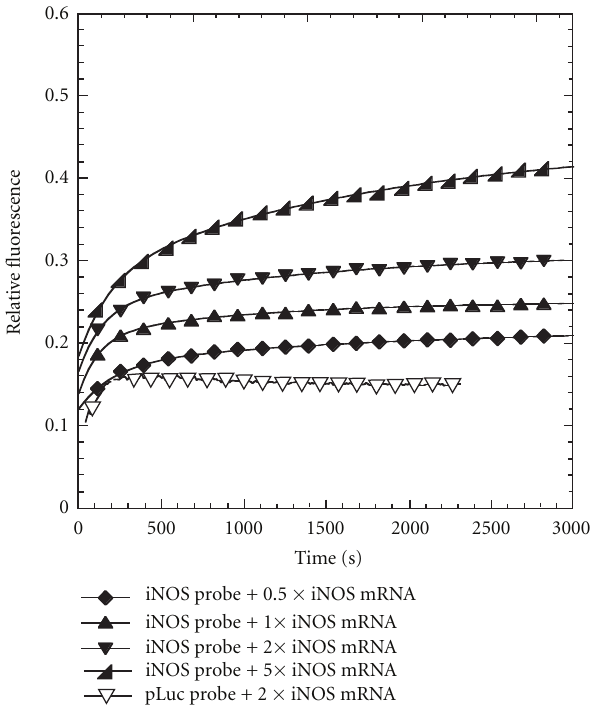
Figure 6: Kinetics of fluorescence activation by strand-displace- ment probes by iNOS mRNA. Fluorescence emission at 525 nm of the iNOS probe (0.05 μ M FAM-iNOS-PNA annealed to 0.1 μ M iNOS-DNA-DABCYL) or pLuc probe (0.05 μ M FAM-pLuc-PNA annealed to 0.1 μ M pLuc-DNA-DABCYL) with the indicated amount of iNOS mRNA. Excitation wavelength: 488nm, temper- ature: 37 ◦